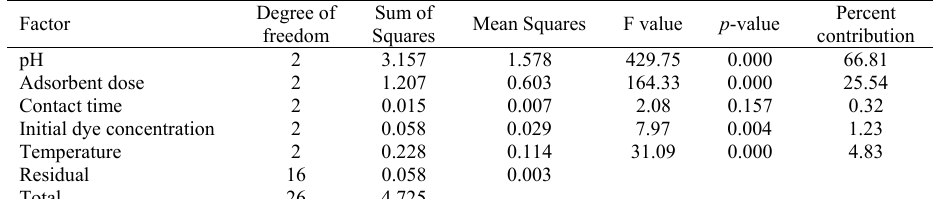
Figure. 3. XRD pattern of Fe 3 O 4 /AC nanocomposite